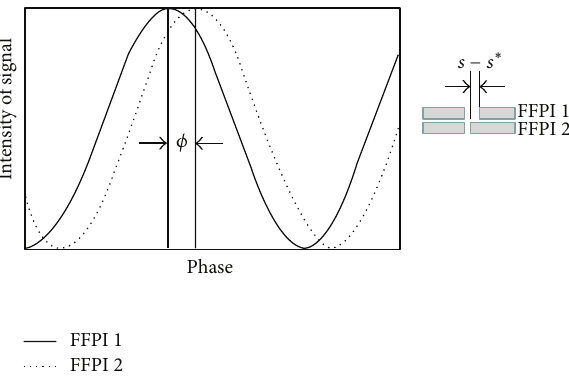
Figure 2: Characteristics of signals of dual-cavity Fabry-Perot